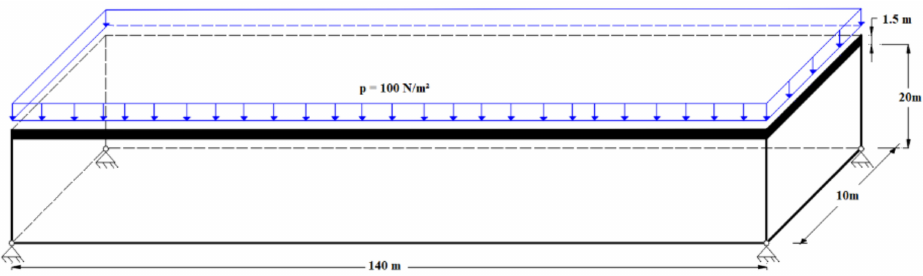
Figure 13. Variation of DTO and RBTO compliance as a reliability index function.